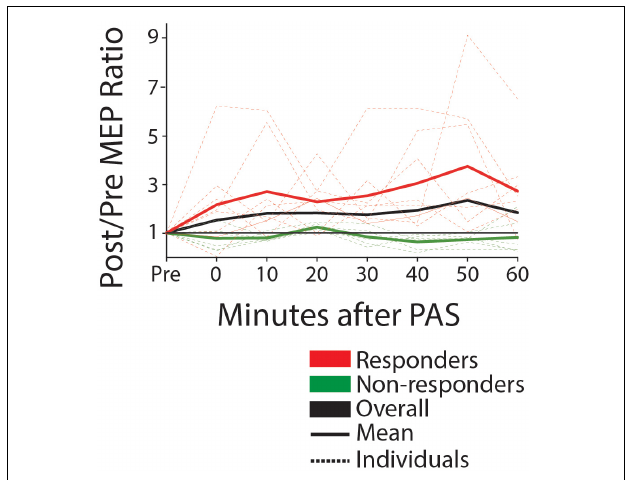
FIGURE 5 | MEP amplitude pre and post-PAS (0–60 min) for responders (mean post > 10% mean pre) and non-responders, off-drug (ratio post/pre). Solid lines show group mean, dotted show individual data. Black line is the mean for the entire group. We note that approximately half of participants are responders, with a mean increase of greater than 200% post versus